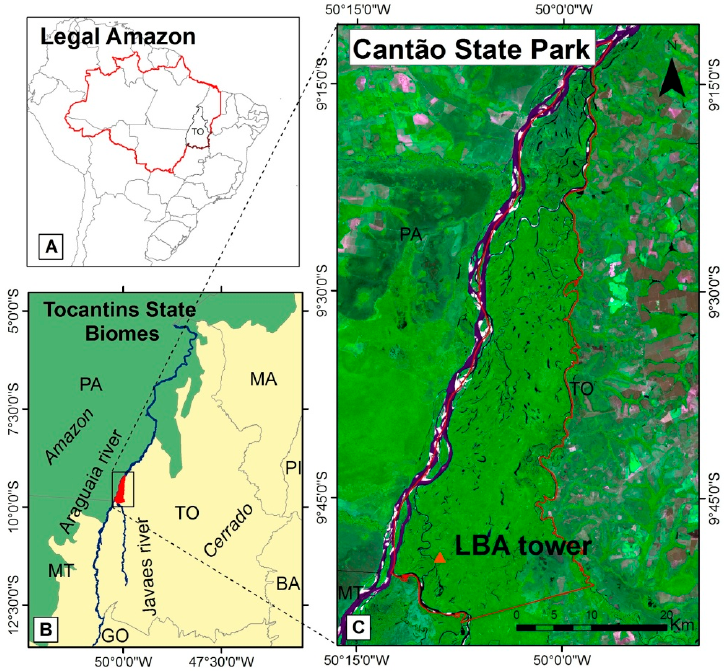
Figure 1. Large-scale biosphere-atmosphere (LBA) eddy flux tower location. ( A ) Tocantins State inside Legal Amazon delimitation (red line), ( B ) Cant ã o State Park location in the transition area between the Amazon and Cerrado biomes (Brazilian Institute of Geographic Statistics (IBGE) delimitation, green and beige), and ( C ) LBA tower inside Cant ã o State Park (Sentinel-2 image, red-green-blue (RGB) composite of June